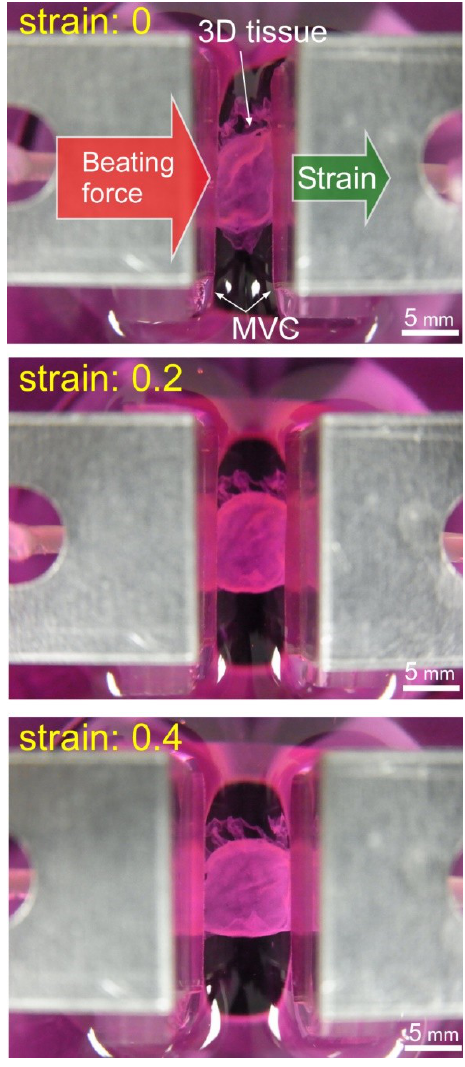
Figure 8. Photos of the cardiac 3D tissue during the tensile test.